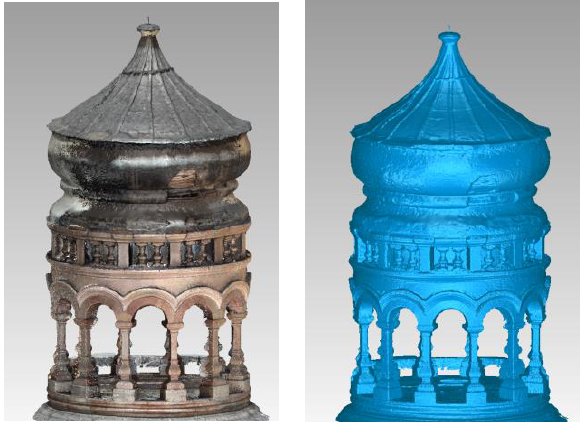
Figure 6: The 3D model of the dome textured (left) and non- textured (right)